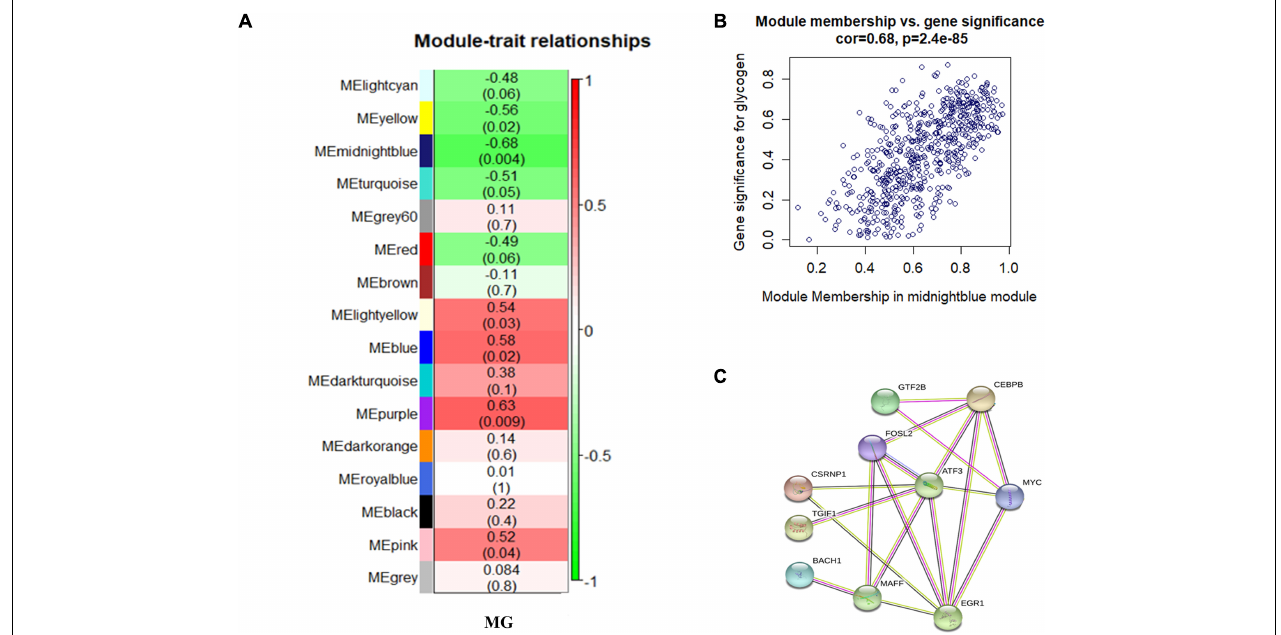
FIGURE 2 | (A) Relationship between gene modules and MG traits in chicken breast muscle tissue. Each row in the table corresponds to a module, and each column to a trait. Each cell contains the corresponding correlation and P value. The module name is shown on the left side of the heatmap. The correlation is shown on the right side of the heatmap, in accordance with the color legend (red means positive correlation, and green means negative correlation). (B) Scatterplots of gene significance versus module membership for MG modules, along with the indicated correlation coefficients and P values. There is a highly significant correlation between GS and MM in the midnight blue module (cor. = 0.82, P = 5.9e-56). (C) Protein–protein interaction network. Each node represents a kind of protein, and the line between the nodes indicates that the pair of proteins has an interaction